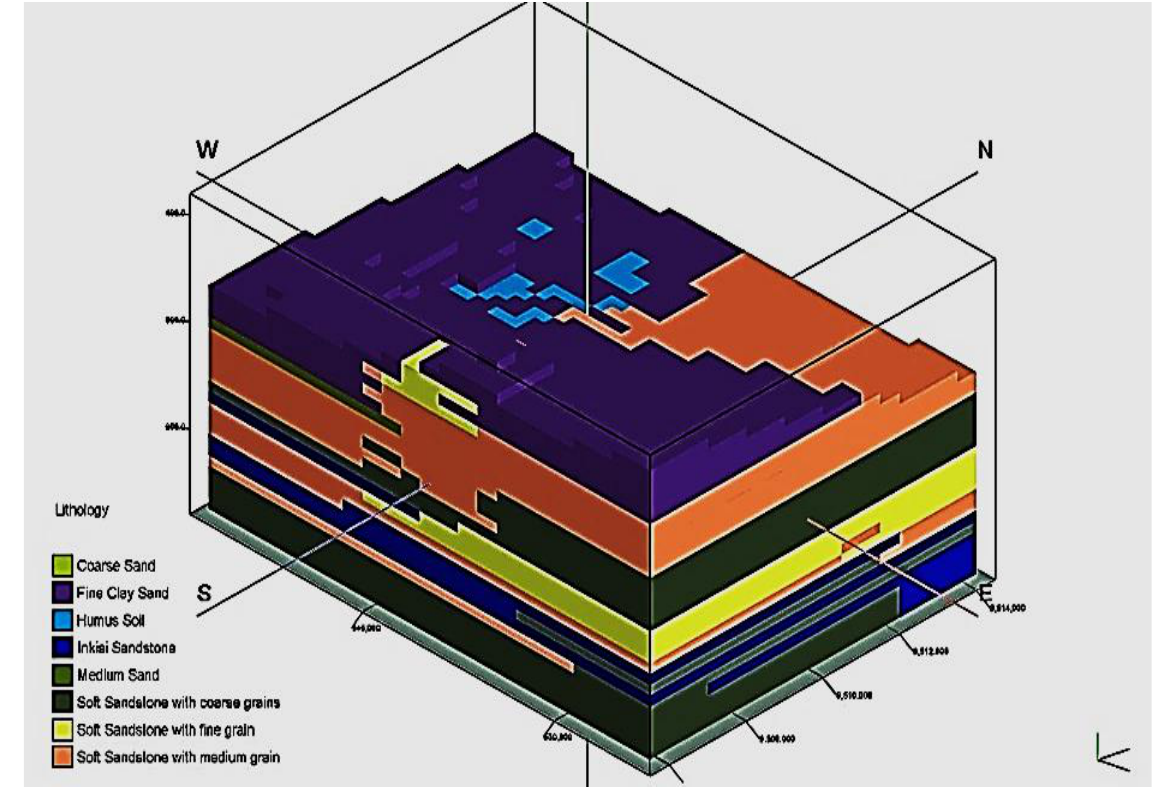
Figure 14. Lithology of the Boreholes.